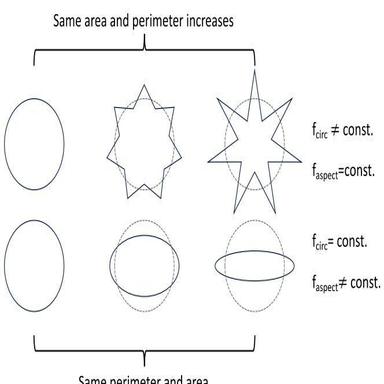
Example of how circularity and aspect ratio values are affected by different geometries and irregularities.